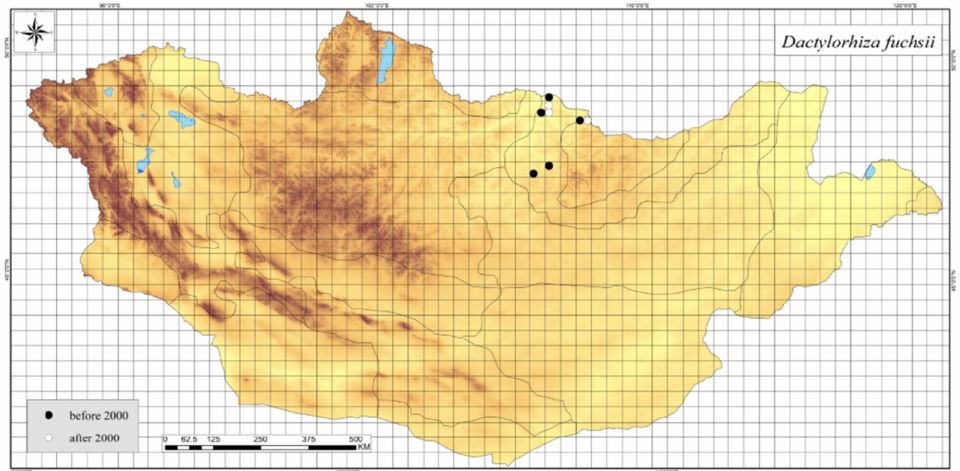
Figure A7. Distribution map of Dactylorhiza fuchsii in Mongolia.